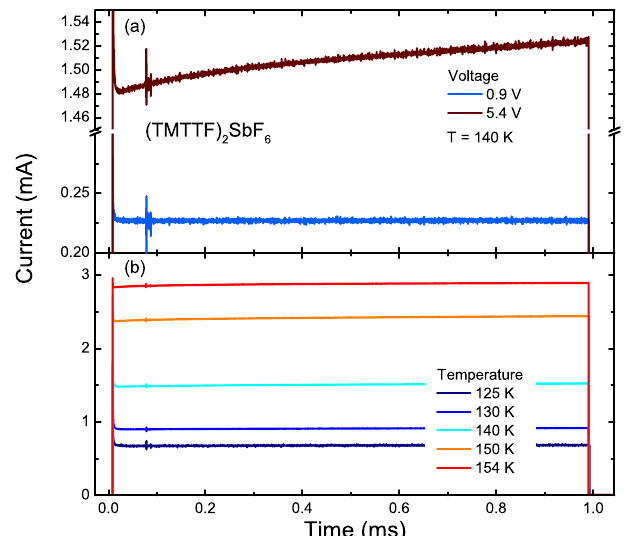
Figure 7. ( a ) Response of the current in (TMTTF) 2 SbF 6 , when 1 ms pulses of two different voltages are applied at T = 140 K; ( b ) Current response plotted for various temperatures below T CO